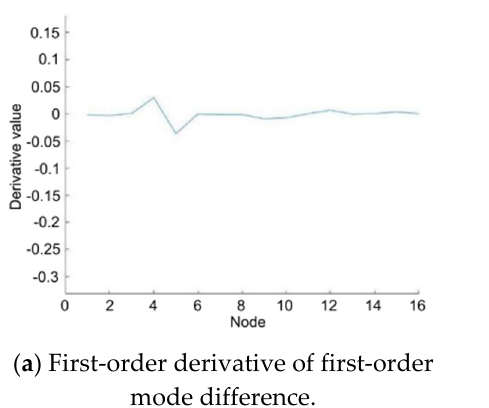
Figure 16. Difference derivatives under Conditions 1 (single-span and nondamaged) and 3 (damage at the 1/4 position).